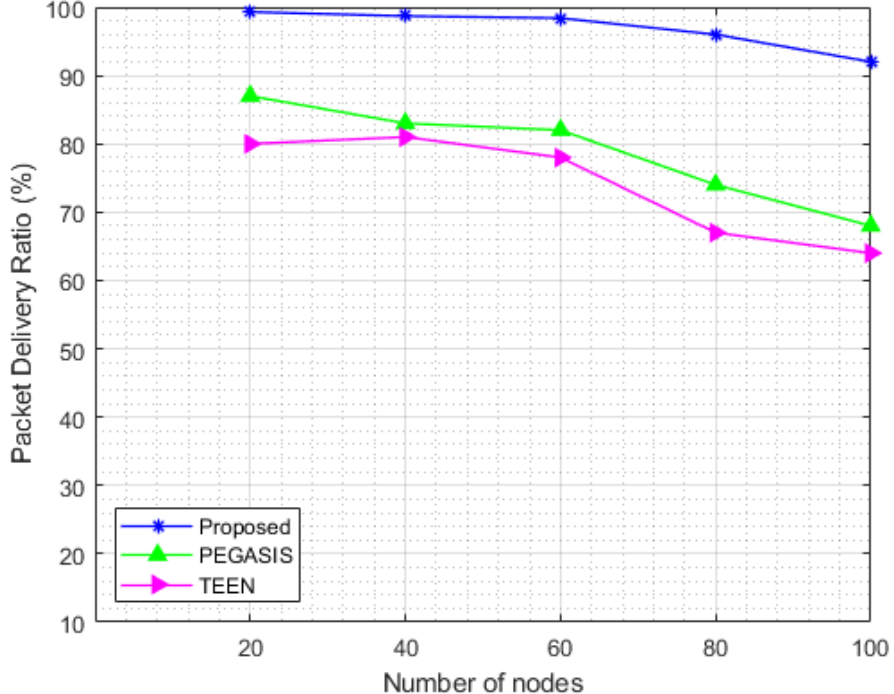
Figure 12. Number of nodes vs. packet delivery ratio (100 nodes).